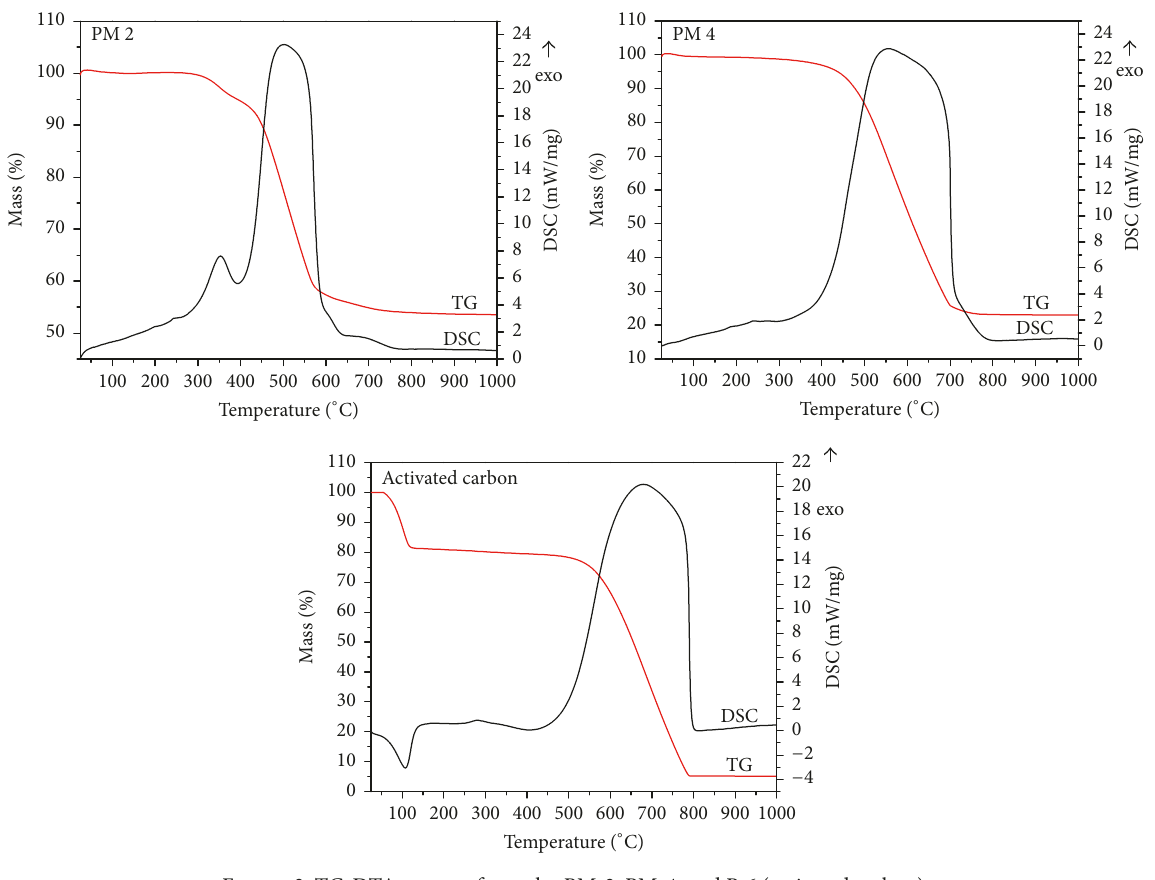
Figure 2: TG-DTA curves of samples PM-2, PM-4, and P-6 (activated carbon).